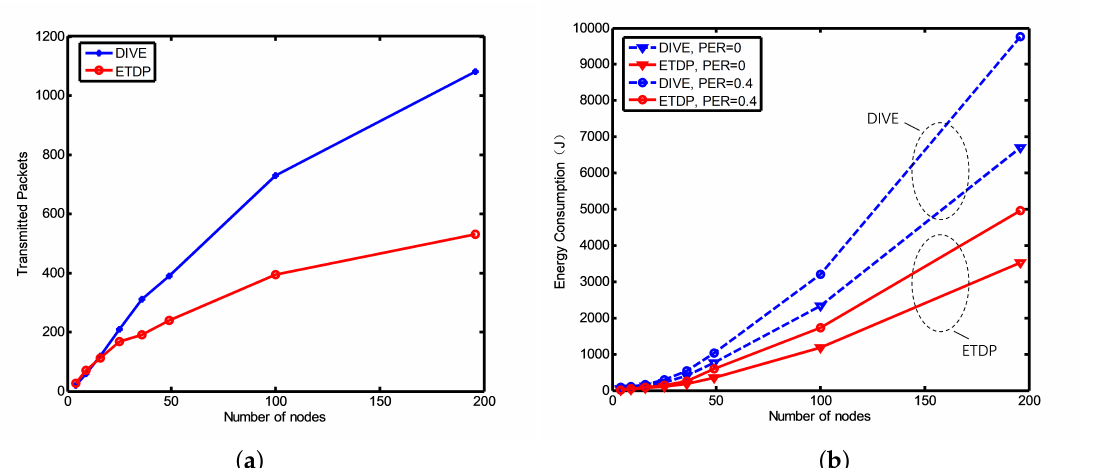
Figure 7. ( a ) The number of transmitted TD packets, PER = 0; ( b ) The network topology discovery energy consumption versus packet error